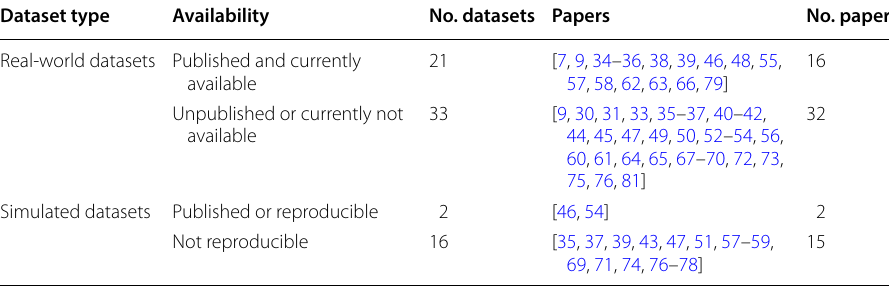
Table 8 Types of datasets used in method evaluation and their availability online or reproducibility, the total number of datasets used for each type of dataset and the respective papers and the total number of papers that used those datasets Dataset